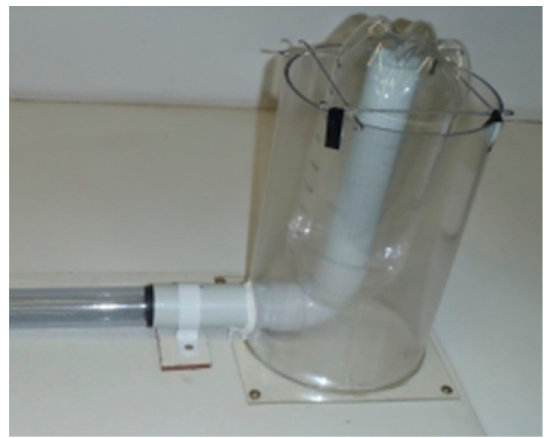
Figure 5. Photograph showing the easy-to-construct spirometer.